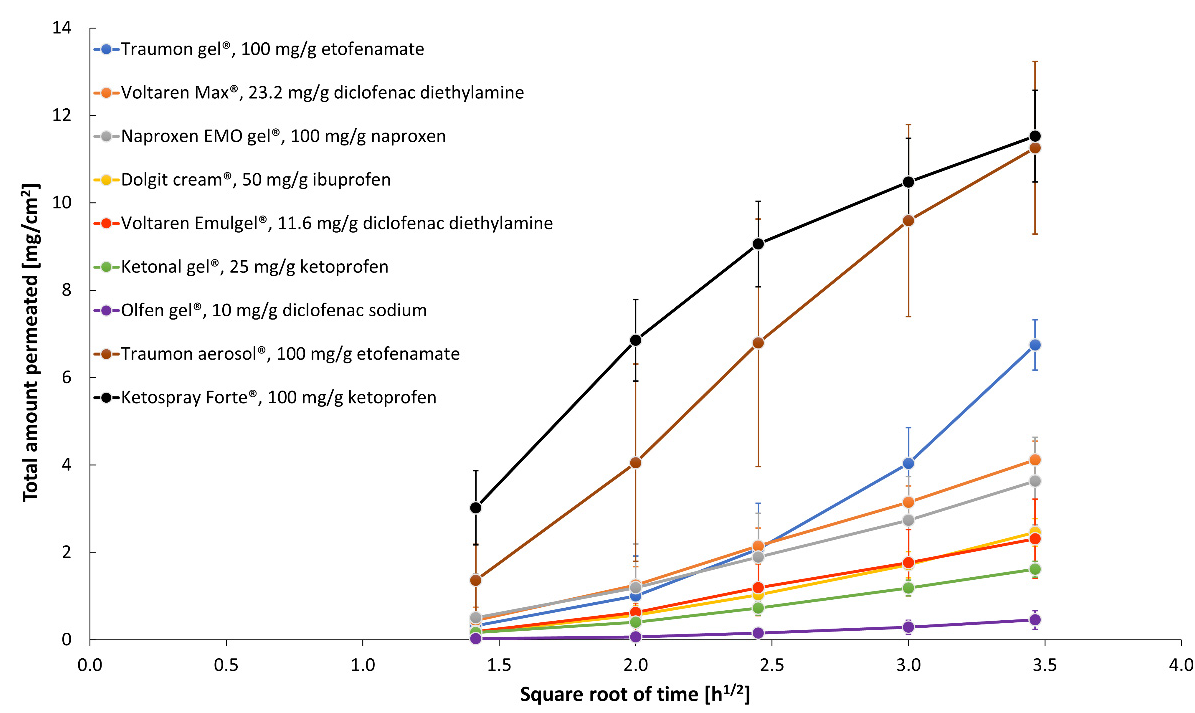
Figure 3. Permeation profiles (mean ± SD; n = 6) of NSAIDs from selected topical products across Strat-M ® membrane obtained in optimized in vitro test conditions.